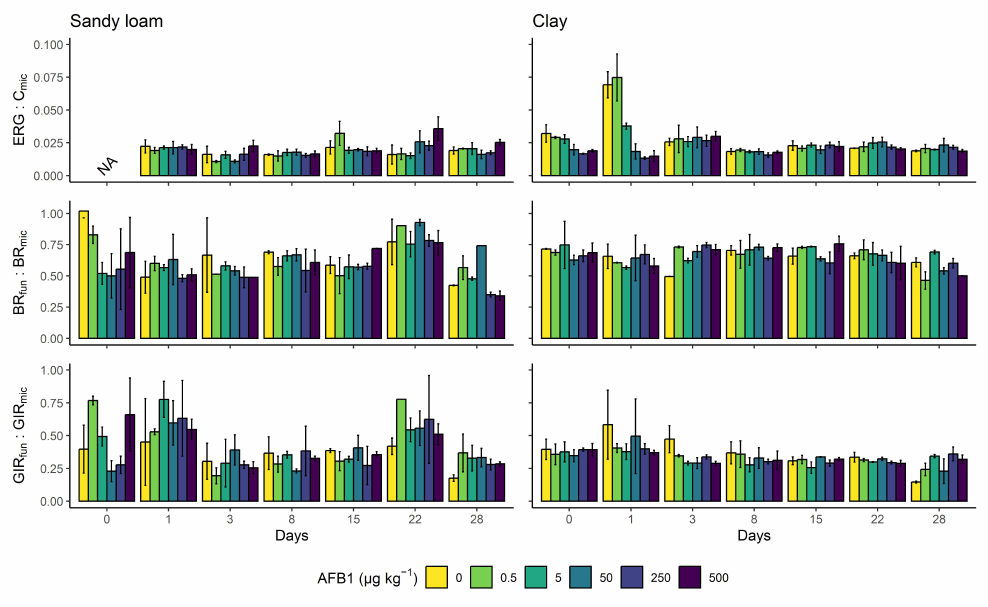
Figure A5. Biomass and activity ratios: Fungal-to-microbial ratios for the biomass (ERG:C mic ), basal respiration (BR fun :BR mic ), and glucose-induced respiration (GIR fun :GIR mic